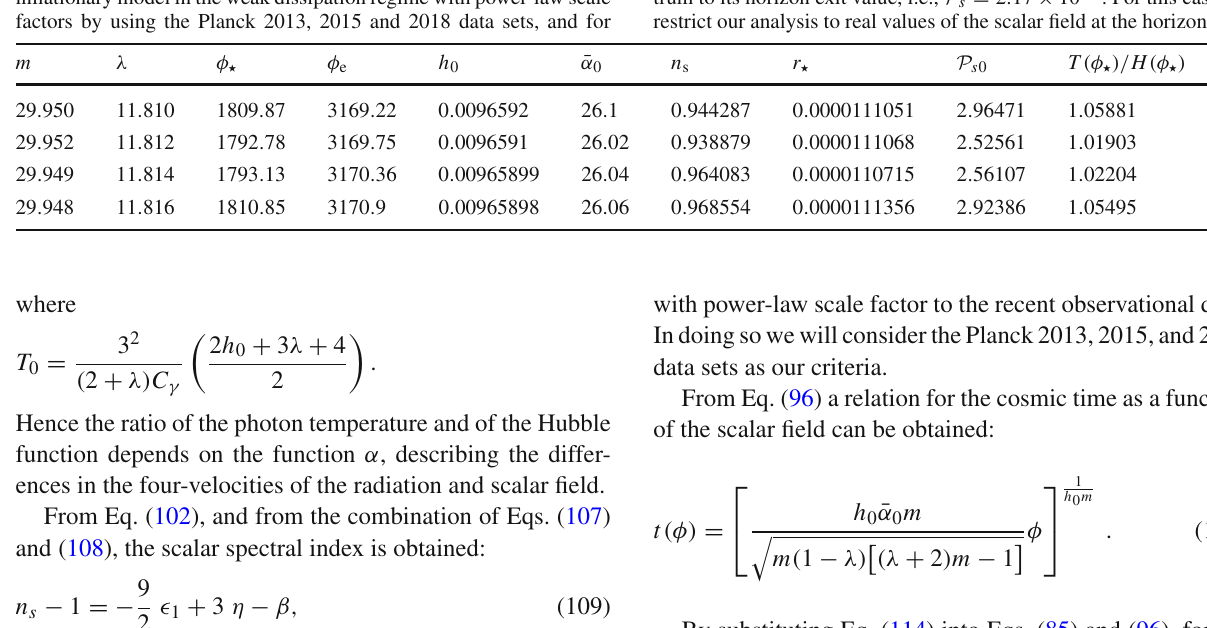
C γ = 50. To obtain the presented results we have fixed the power